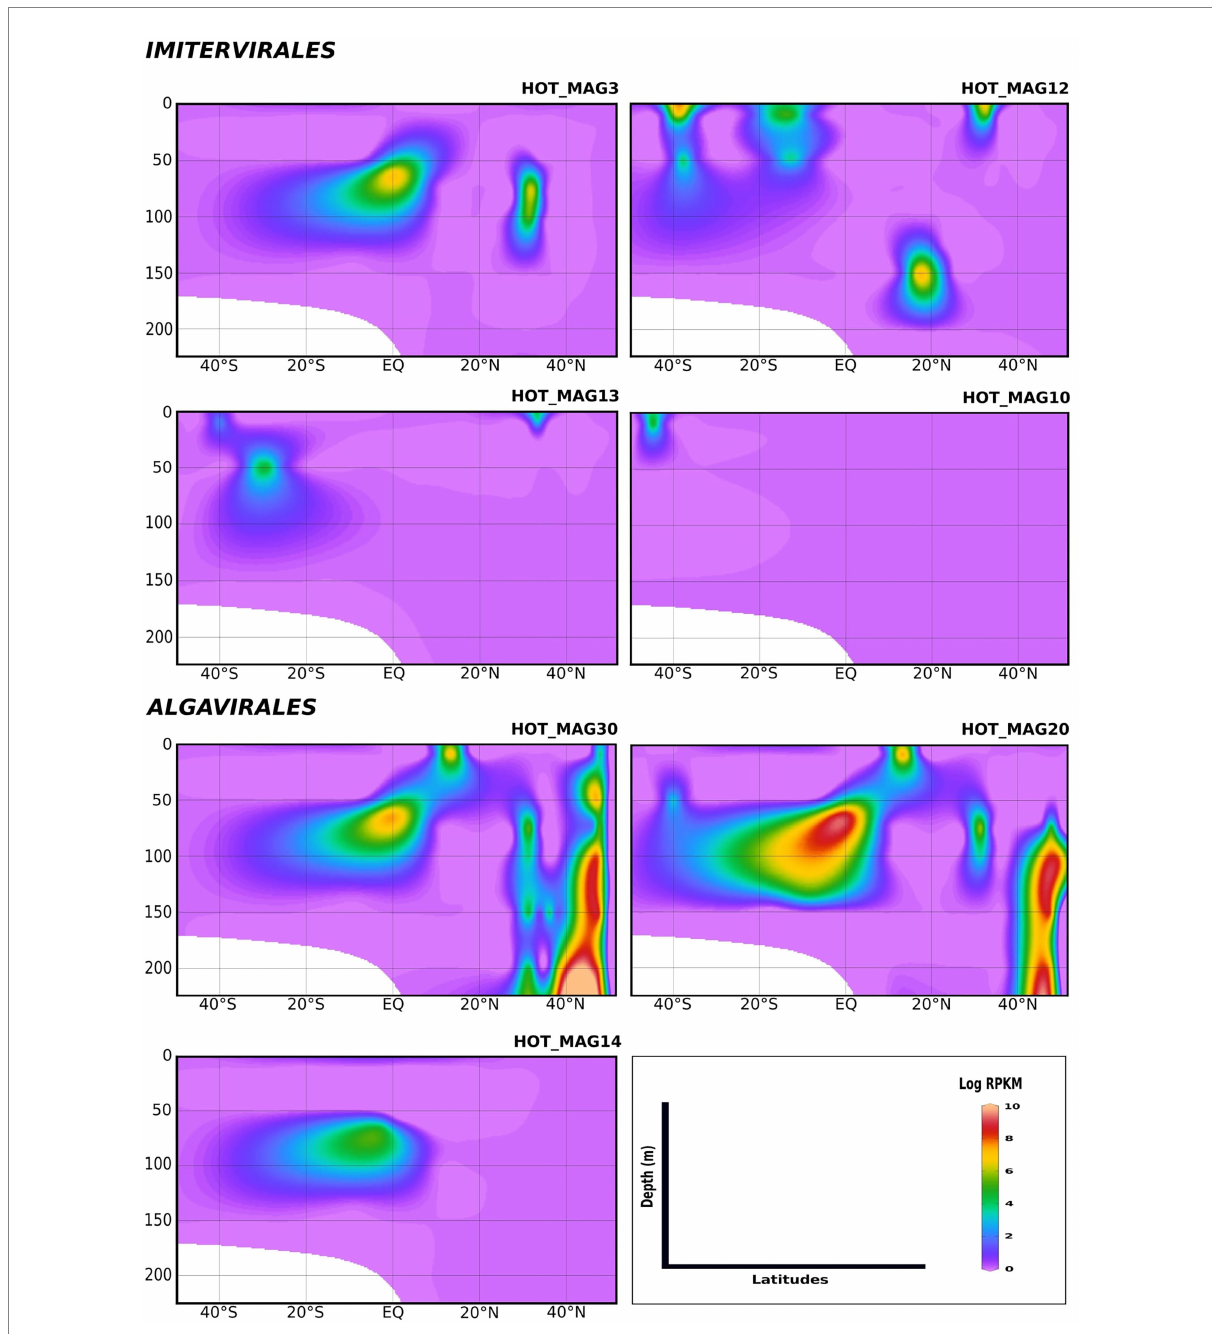
FIGURE 4 Environmental distribution of the HOT MAGs across a depth profile of the GA02 transect (North Atlantic to South Atlantic). The contour plots were drawn based on the results from mapping GA02 metagenome dataset onto the 11 MAGs (see Materials and methods for details). The total abundance of the MAGs was calculated based on RPKM. Y-axis and x-axis represent depths(m) and latitudes, respectively and the colorful bar refers to the log of total abundance (RPKM) for each of the MAGs (high abundance = red and low abundance = purple). HOT_MAGs (22, 4, 60) are not shown as they were not found in the GA02 metagenomic dataset. HOT_MAG5 is also not presented as it is closely related to HOT_MAG3 and its abundance is almost the same as